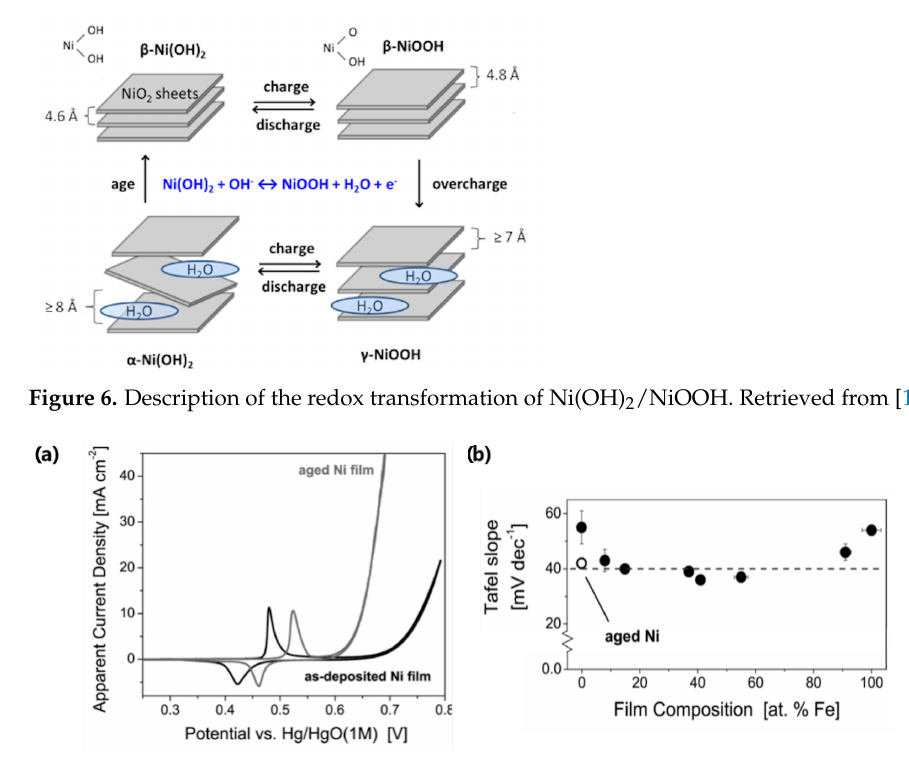
Figure 7. ( a ) Cyclic voltammograms of as-deposited Ni film and aged Ni film. ( b ) Tafel slopes for the different compositions of Ni-Fe oxide films. Modified from